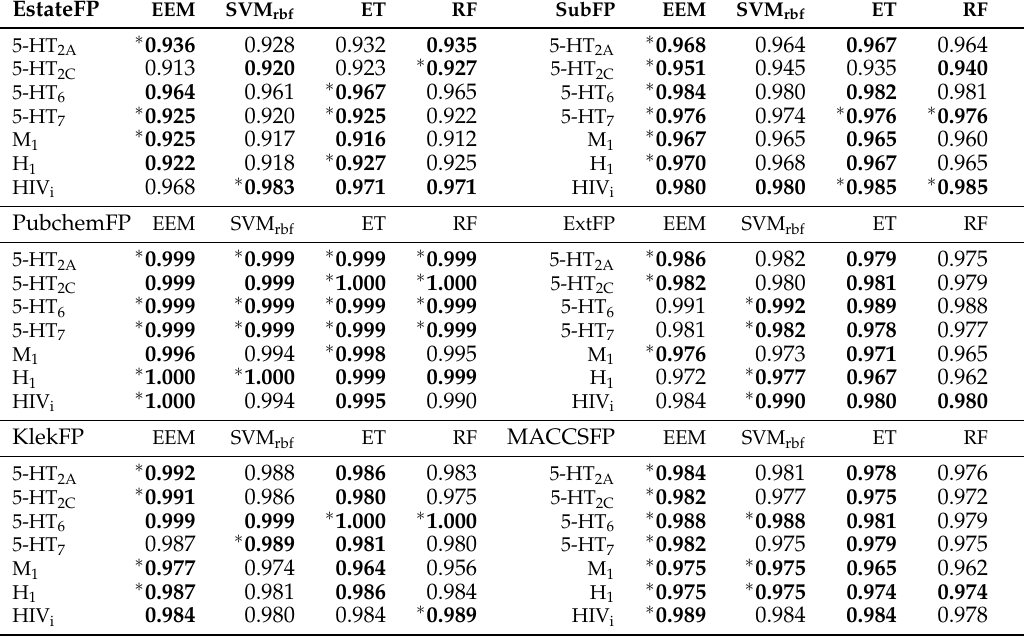
Table 4. BAC results for actives/true inactives and DUDs datasets. Asterisk indicates the highest BAC values obtained for a particular target/fingerprint pair.